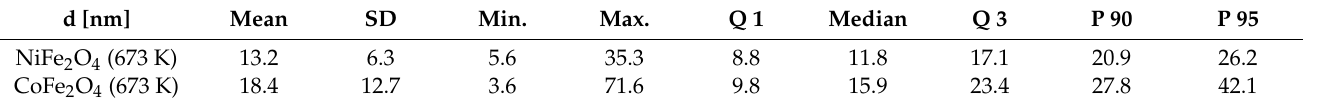
Figure 4. TEM images of the NiFe 2 O 4 ( a ) and the CoFe 2 O 4 ( b ) and the carbon layer on their surfaces. Box plot diagram of the particle size analysis ( c ). Table 3. Mean particle sizes (nm) of the identified phases based on TEM